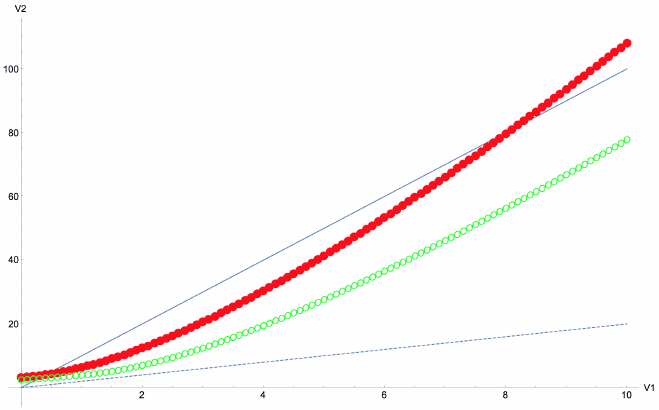
Figure 4: This numerically generated plot shows the tie points of the double and triple interval in the curve with solid red points for density e x 2 and the curve with the empty green points for density e x 4 . The solid blue line is V 2 = 10 V 1 and the dashed blue line is V 2 = 2 V 1 . Note that the solid blue line intersects the red curve